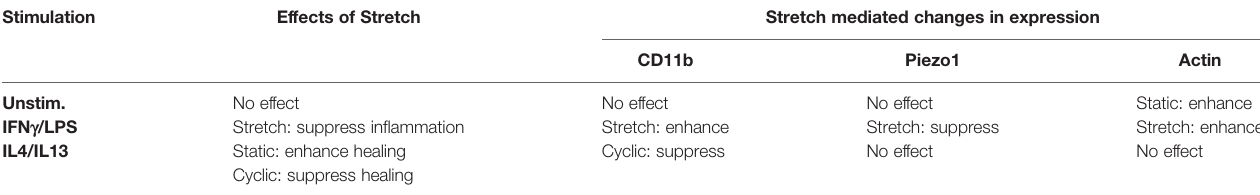
TABLE 1 | Summary of stretch mediated changes in macrophage function. Stimulation Effects of Stretch Stretch mediated changes in expression